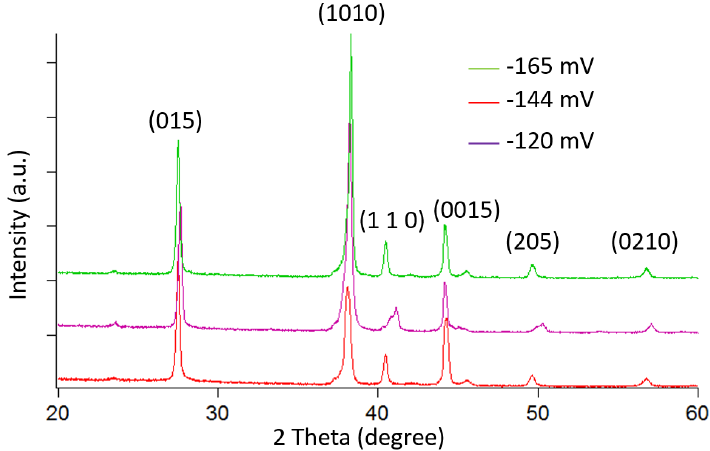
Figure 20. XRD pattern of the SbTe films at different deposited potentials.